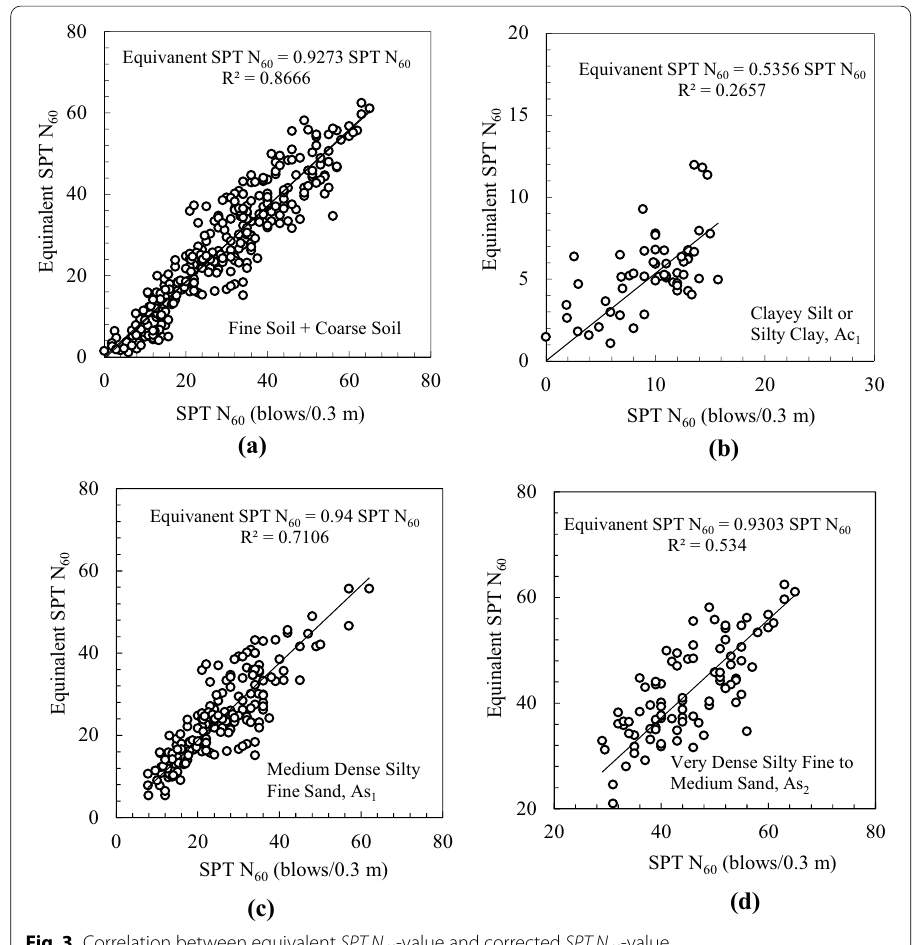
Fig. 3 Correlation between equivalent SPT N 60 -value and corrected SPT N 60